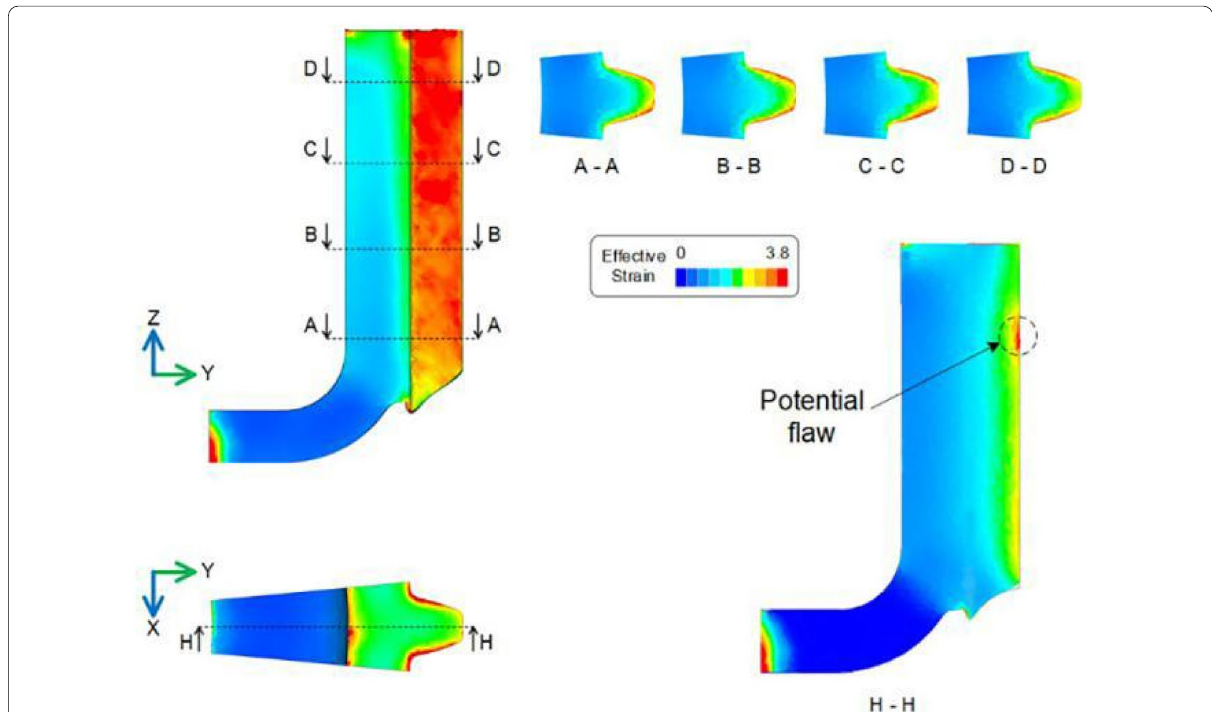
Figure 13 Strain distribution after forming based on U-CDZ method under 60 kN counter